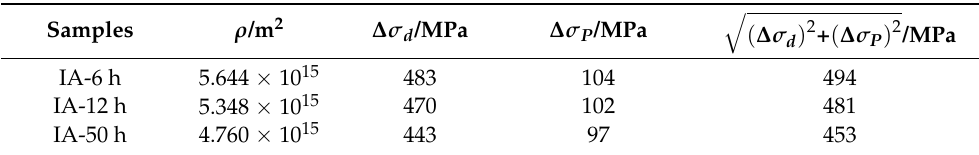
Table 4. The calculated dislocation density, dislocation strengthening increment, and precipitation strengthening increment of the